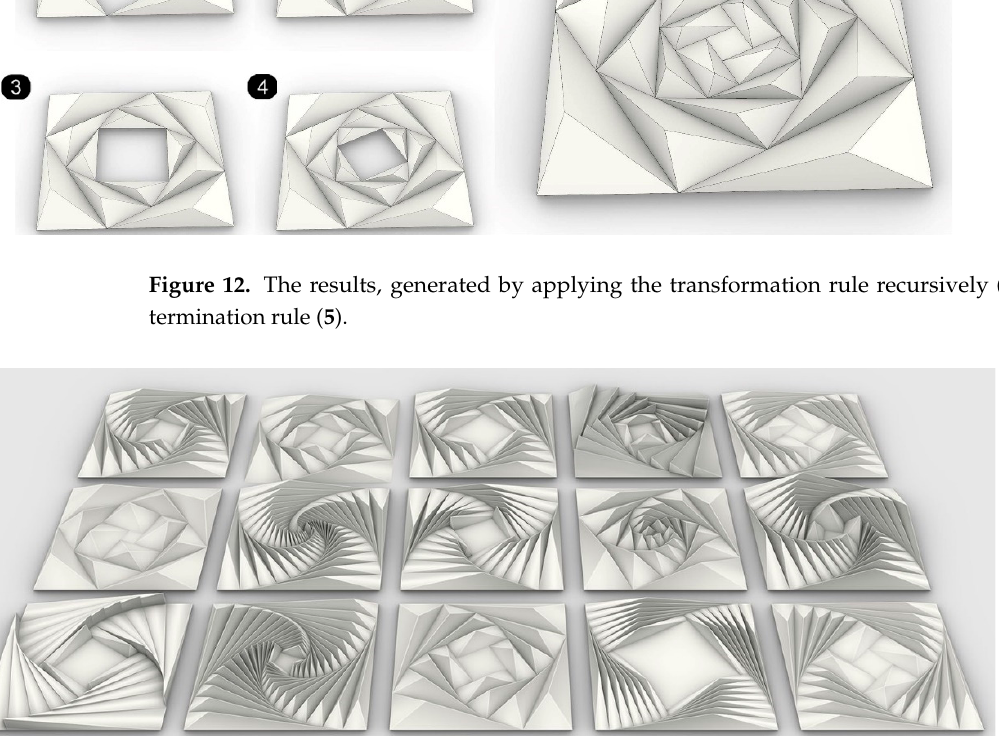
Figure 13. The results, generated by applying different transformation rules, defined with corner- weight , median-weight , height , rotation , and repeat parameters, and different termination rules.